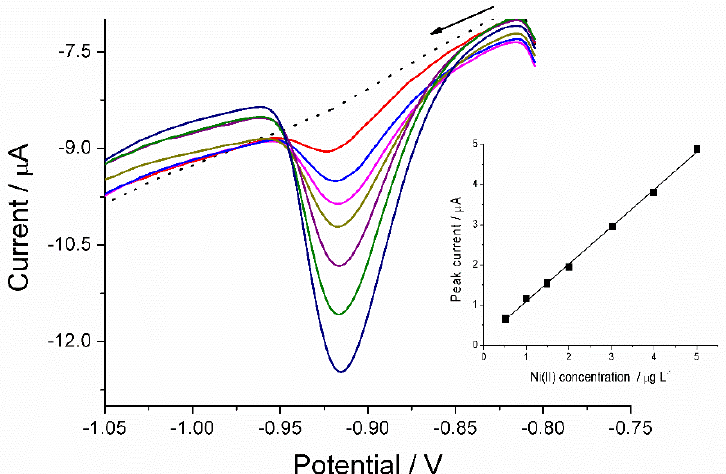
Figure 4. AdCSVs at Bi-PPCE for increasing concentration of Ni(II) in the range of 0.5 to 5 µg∙L −1 in 0.1 M ammonia buffer solution containing 10 mg∙L −1 Bi(III), 1 × 10 −5 mol∙L −1 dimethylglyoximate (DMG) and 0.01 mol∙L −1 tartrate. The dotted line was recorded in the absence of Ni(II). Deposition at −1.1 V for 60 s followed by accumulation at −0.8 V for 120 s; equilibration time of 15 s. Other experimental conditions as in Figure